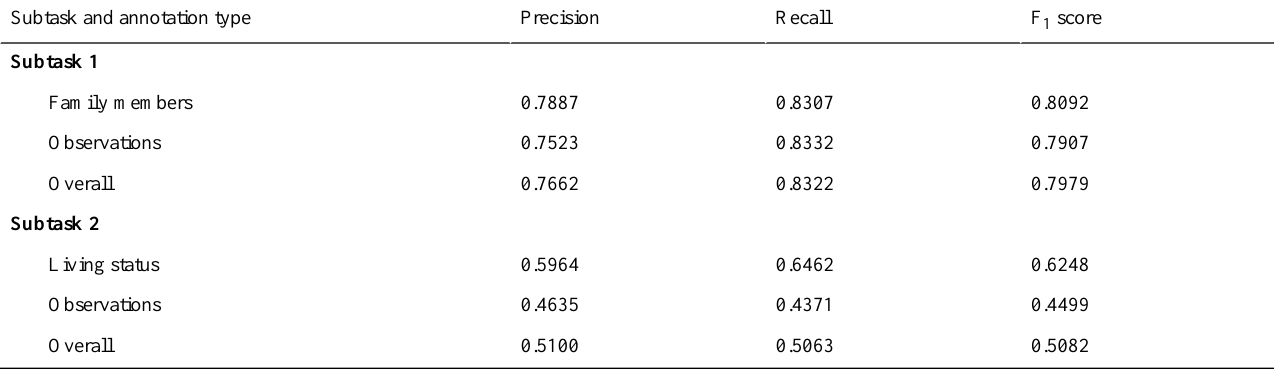
Table 6. Test results for both subtasks using the final hybrid solution: rule-based engine combined with deep learning module for observation